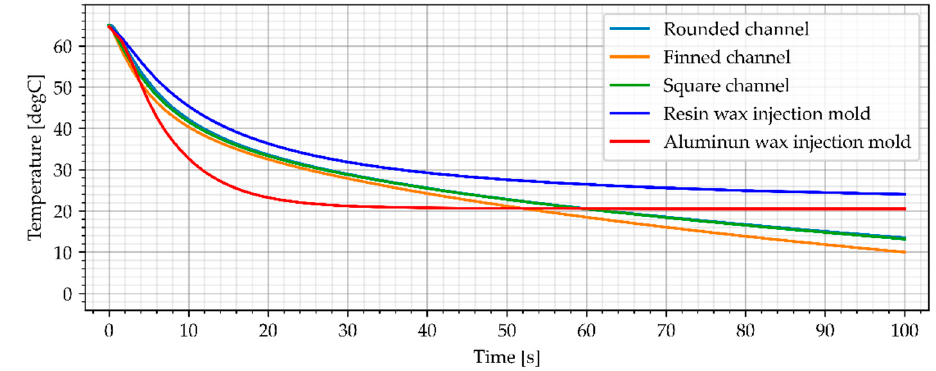
Figure 18. The sample temperature for air cooled wax injection molds (middle point).